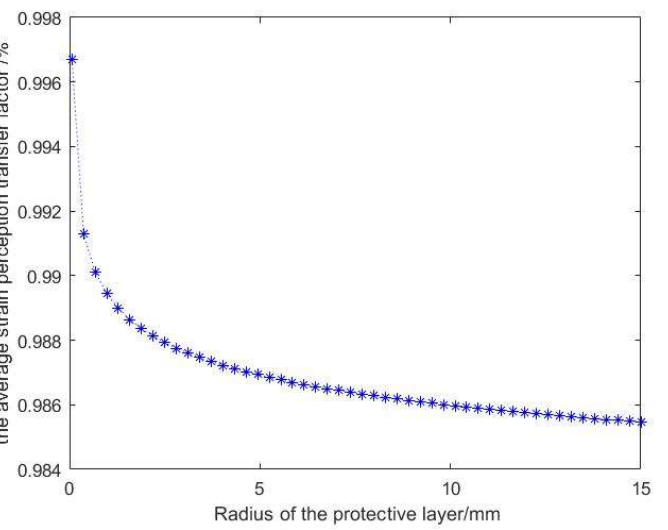
Figure 6. Effect of the radius of the protective layer on the average strain perception transfer factor.